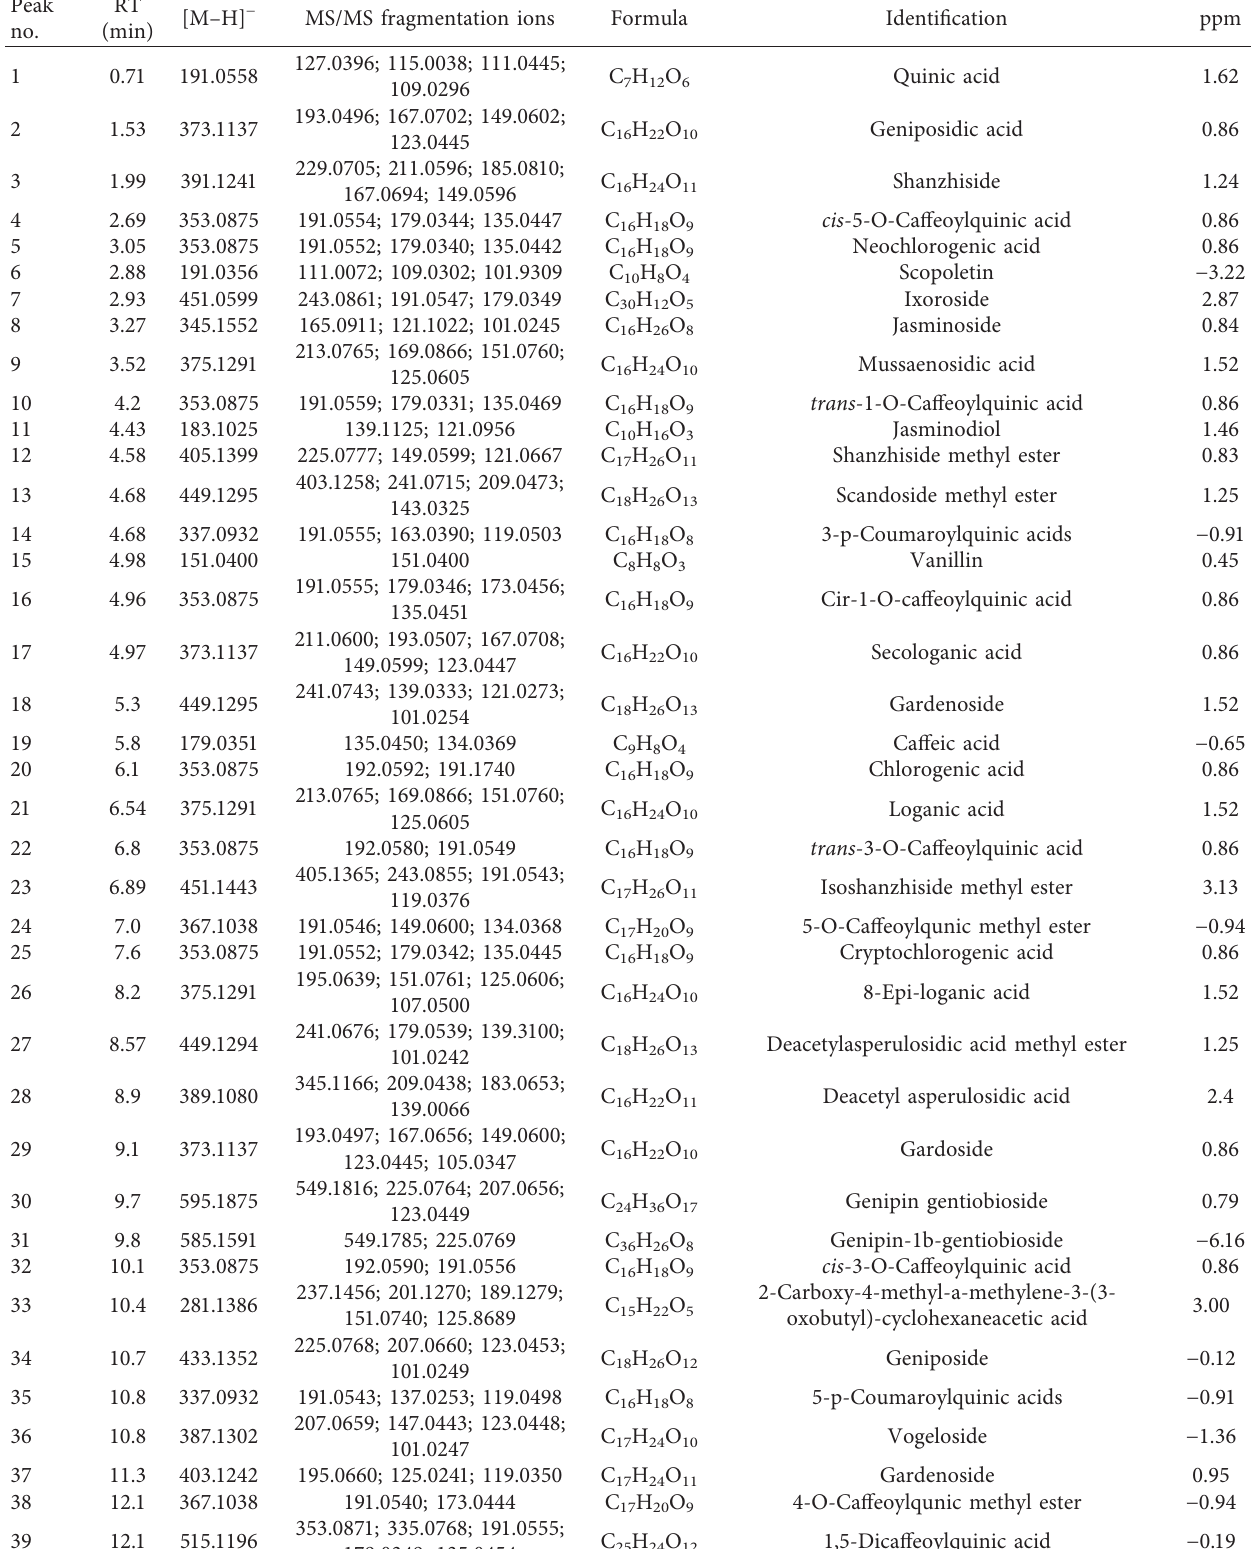
Table 1: UPLC/Q-TOF-MS data and identification 67 compounds in RDN